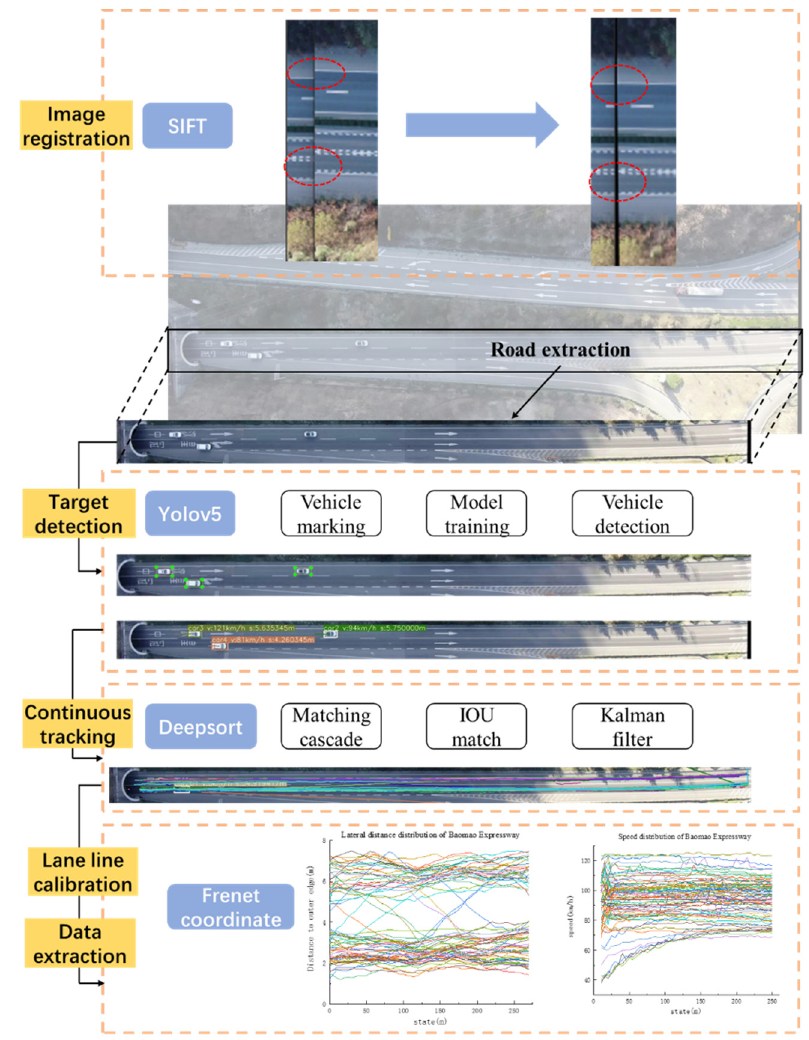
Figure 3. Data extraction process.